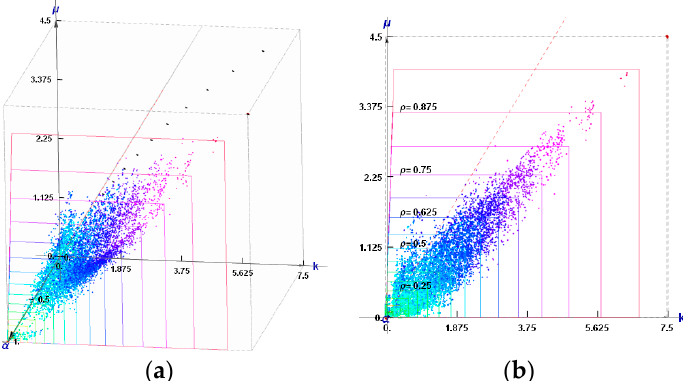
Figure 14. ( a ) The sets of points of coordinates ( k H , µ H , α H ) corresponding to the periodic composites of cubic symmetry (see the two-phase cell shown in Figure 10). The plane k = µ is marked by a dashed red line (note that the plane k = µ is visible as a line) Black points on the plane α = 0 refer to microstructures from Figure 11; ( b ) The set of points ( k H , µ H , α H ) projected onto α H = 1